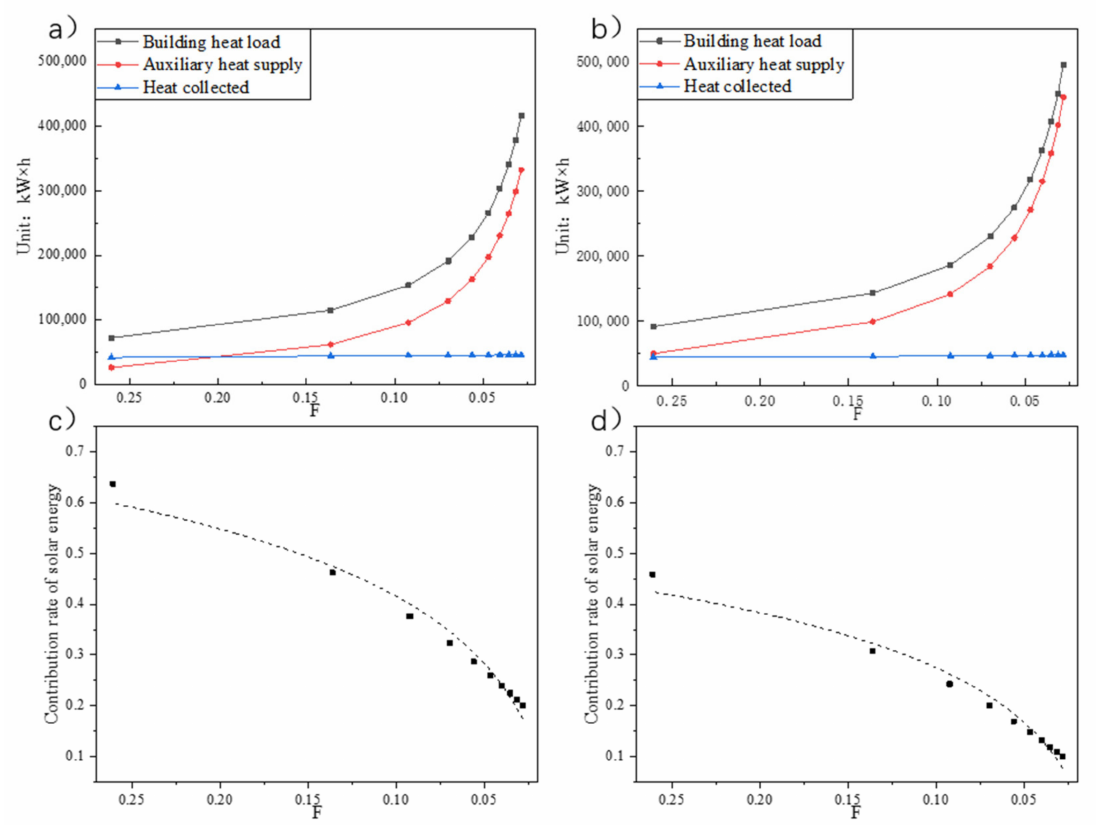
Figure 2. When F is the independent variable: the analysis of the three kinds of heat of office building and three-star hotel is shown in graph ( a ) and graph ( b ); the analysis of solar energy guarantee rate is shown in graph ( c ) and graph ( d